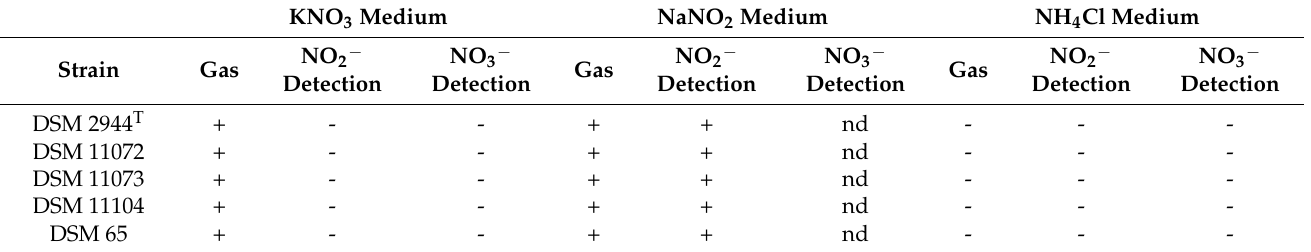
Table 4. Overview of anaerobic denitrification by the investigated strains. The cultivation was performed in airtight Hungate tubes filled with a special nutrient solution. The degradation of nitrate and nitrite, as well as the subsequent synthesis of N 2 gas, was used to determine the reduction of com- pounds. “-”: no N compound detected/no gas detected; “+”: N compound detected/gas detected. KNO 3 Medium NaNO 2